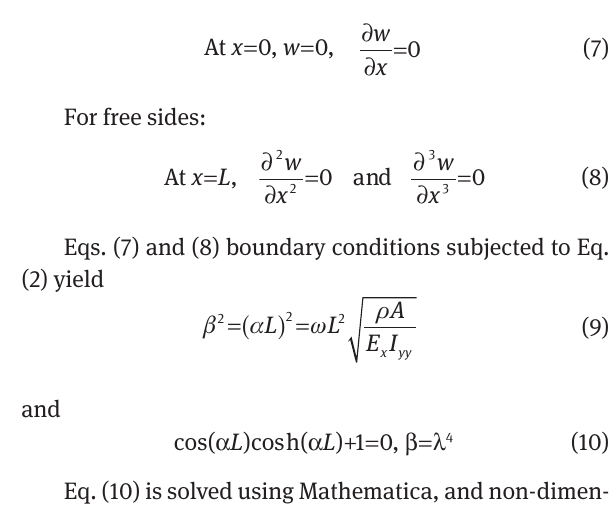
Figure 1 Cantilever laminated composite